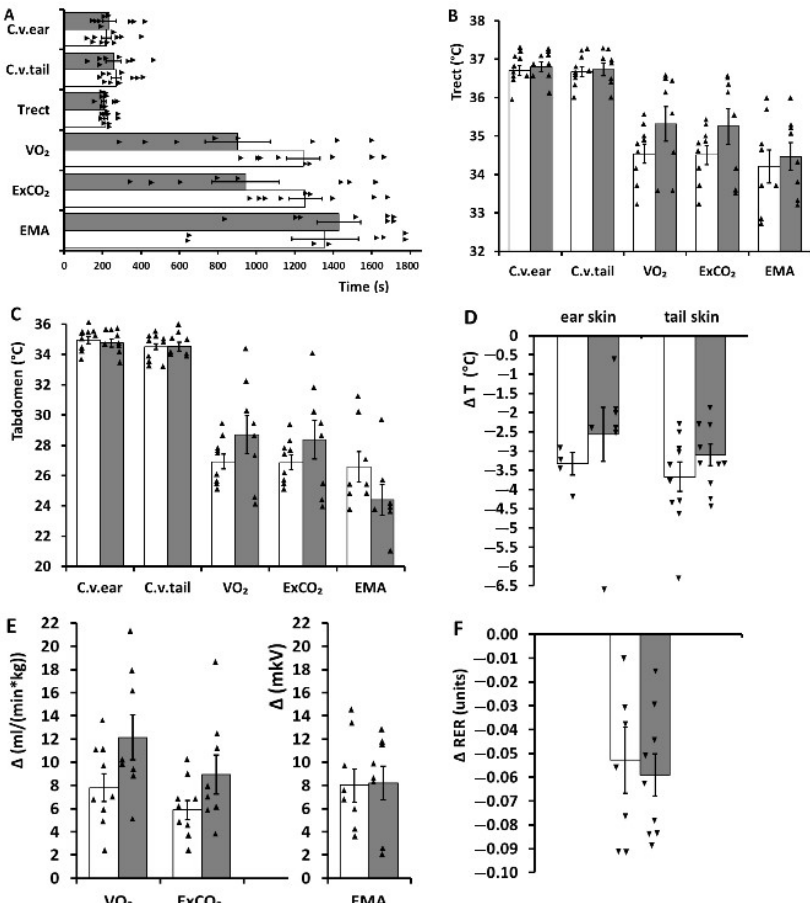
rapid cooling. Triangles represent the individual values of the parameters. In all panels, the data from control animals are represented by open bars, and data from the animals subjected to the pe- ripheral ion channel TRPM8 activation with menthol are indicated by filled bars. Thermoregula- tory responses were compared by the t-test (Statistica 8 software package). p -values are presented in Table S1.